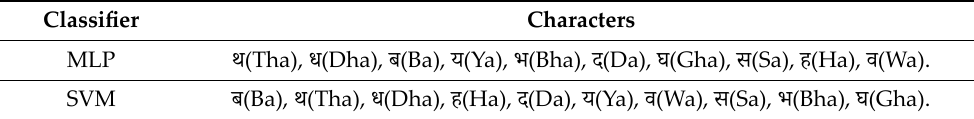
Table 16. Mean F1 score‑wise bottom 10 characters, including all the 15